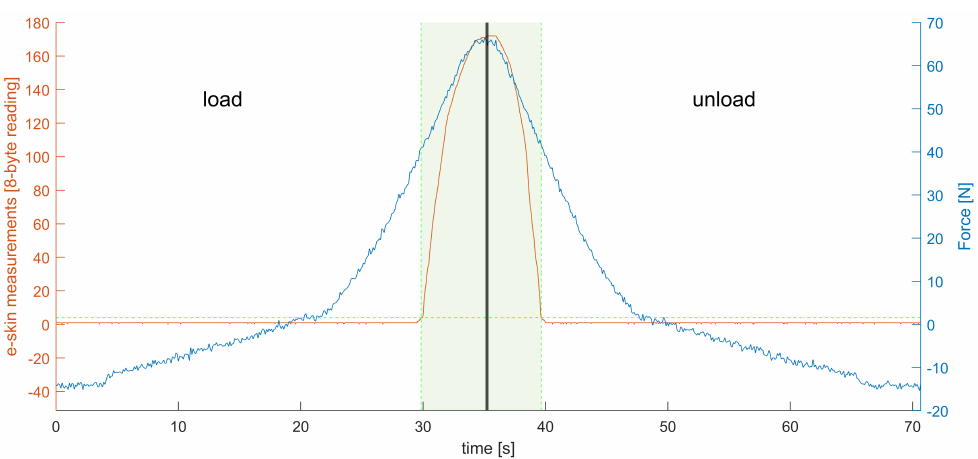
Figure 9. Data recorded while taking measurements from one of the e-skin sensors (row 7, column 19). A thick vertical middle line distinguishes the ‘loading’ phase from the ‘unloading’ phase. The blue line represents the recording from the Hex-e sensor (reference sensor). The orange line represents recordings from the e-skin sensor. The green, horizontal, dashed line is a threshold value based on which narrowing the data range was performed. A data subset used during further processing is indicated by the green shaded area, limited by green, vertical, dashed lines localised in intersections of the threshold line and the e-skin